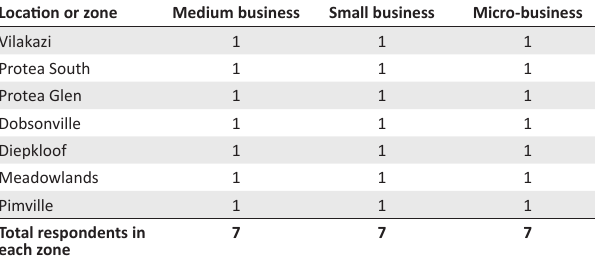
TABLE 3: Locations or zones of respondents in